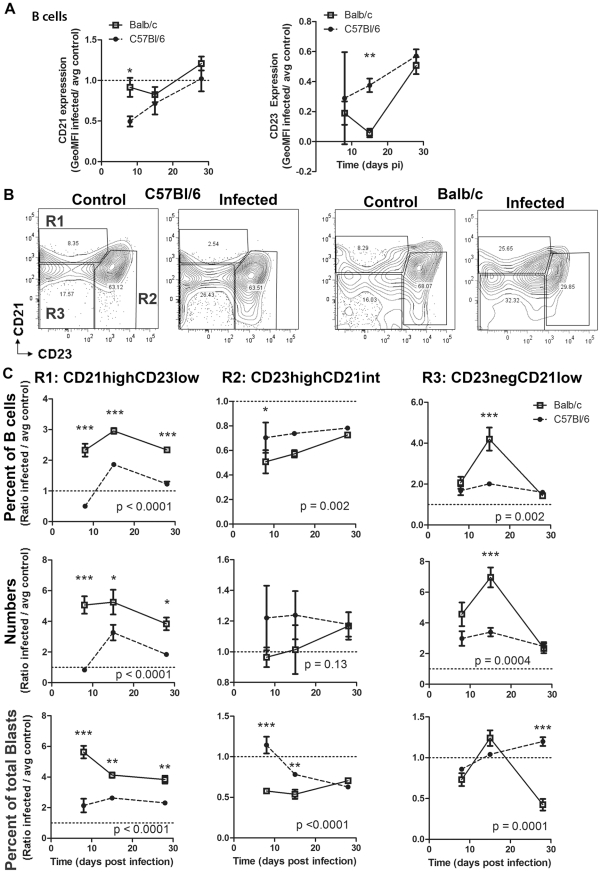
Splenic B cell subset changes.Splenoctyes were harvested from infected and control mice at days 8, 15, or 28 post infection and analyzed by surface markers for B cell populations. A, Analysis of CD21 and CD23 expression levels over the course of infection. B, Representative contour plots from day 8 post-infection show gates used for subset determination. C, These plots show the relative change in splenic B cell phenotype between infected and control mice. The first row graphs show percent of B cells accounted for by each of the subsets, the second row graphs show the absolute numbers for each population, the third row graphs shows the percent of B cell blasts accounted for by each of the subsets. In these sets of graphs, the y-axis shows the ratio of infected to average control (n = 5 mice per group per time-point). Graphs for a given population are underneath that title. Balb/c are represented by open squares, solid line; C57Bl/6 mice by closed circles, dashed line. Reported p values indicate the result of 2-way ANOVA analysis between Balb/c and C57Bl/6 mice. * p<0.05, ** p<0.01, *** p<0.001 by Bonferroni post-test after 2-Way ANOVA comparing Balb/c and C57Bl/6 models (p values reported on graphs) and/or Student's t test.